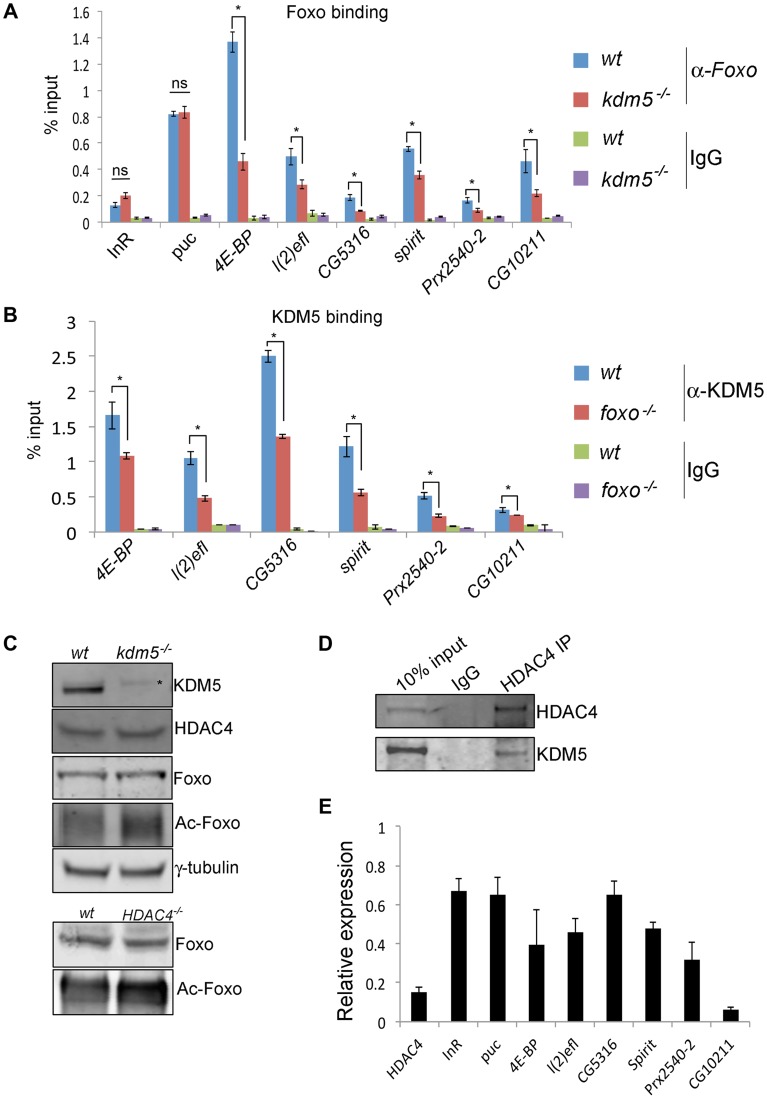
KDM5 is required for efficient recruitment of Foxo to a subset of its target promoters.(A) ChIP using anti-Foxo [86] to the FHRE region of the InR, puc, 4E-BP, l(2)efl, CG5316, spirit, Prx2540-2 and CG10211 promoters in wildtype (w1118) and kdm510424/K6801 mutant larvae. * p<0.05. (B) KDM5 ChIP to the FHRE in the InR, puc, 4E-BP, l(2)efl, CG5316, spirit, Prx2540-2 and CG10211 promoters in wildtype (w1118) and foxo21 mutant 3rd instar larvae. * p<0.05. IgG is included as an additional control for non-specific binding in A and B. (C) (top) Levels of KDM5, HDAC4, Foxo, acetylated Foxo and the loading control γ-tubulin in wildtype and kdm5K6801 mutant larvae (anterior half of 3rd instar larvae). Levels of acetylated Foxo were determined by immunoprecipitating Foxo from larval extract and probing Western blot with an anti-acetyl-lysine antibody. * indicates non-specific band in KDM5 blot. (bottom) Levels of Foxo and acetylated Foxo in HDAC4KG09091 mutant larvae. (D) Immunoprecipitating HDAC4 from larval extracts efficiently pulls down HDAC4 and also co-precipitates KDM5. Lysate used was from 3rd instar larvae. (E) Real time PCR showing levels of HDAC4, InR, puc, 4E-BP, l(2)efl, CG5316, spirit, Prx2540-2 and CG10211 mRNA in HDAC4KG09091 homozygous 3rd instar larvae showing that all of these genes are significantly downregulated. All genes shown were significantly downregulated (p<0.05).